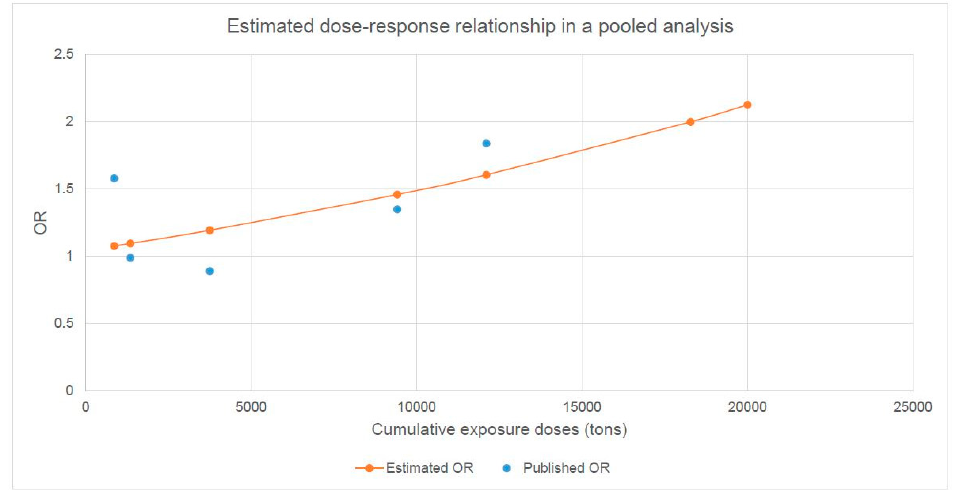
Figure 5. Extrapolated course of the dose–response relationship between heavy lifting and the risk of hip osteoarthritis in a pooled analysis of the data given by Vingard et al. 1991 [13] and Rubak et al. 2014 [18].